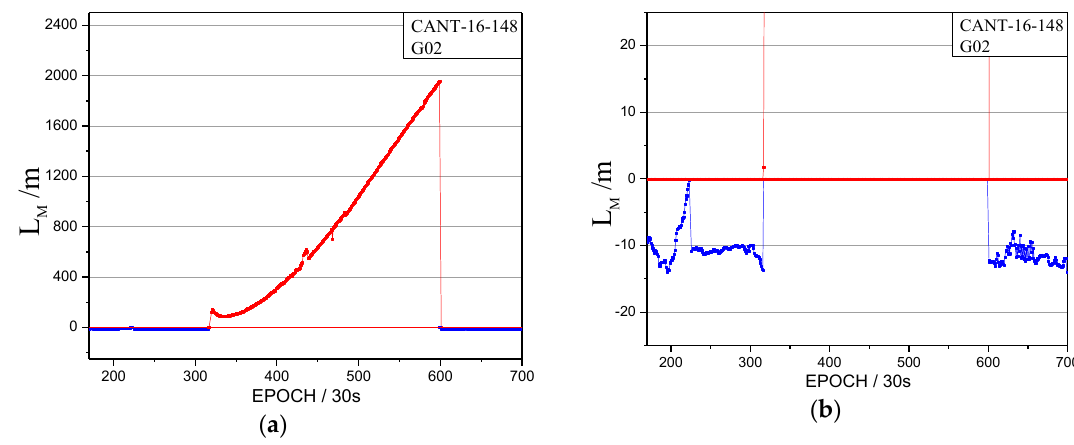
Figure 16. The satellite factors of the orbital maneuver for G02 on 27 May 2016. ( a ): The normal vertical axis scale shows overall information; ( b ): The amplified vertical axis scale shows more detailed information.